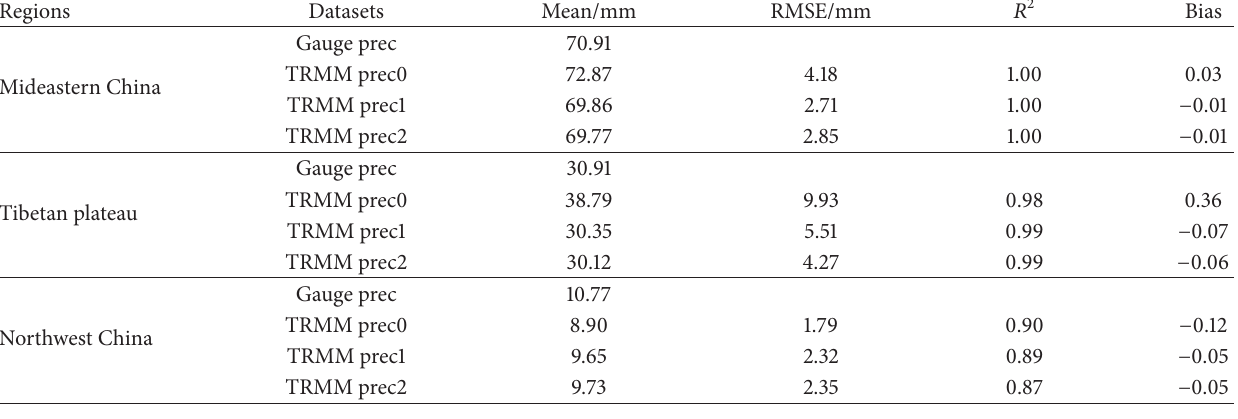
Table 2: Validation of monthly original/corrected TRMM precipitation in the three regions in 2014 at regional scale. Regions